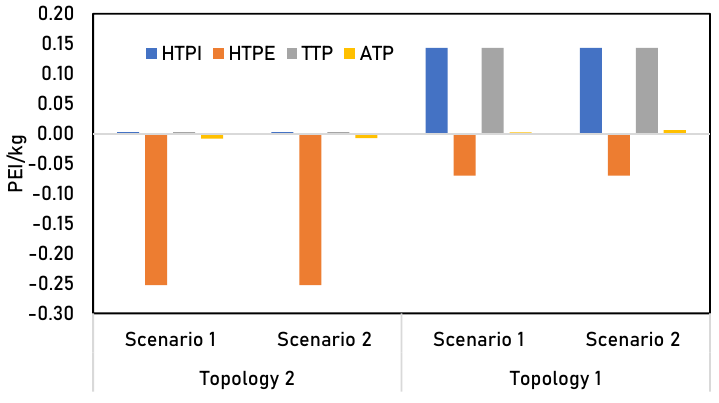
Figure 16. Generation rates of PEI for toxicological categories.